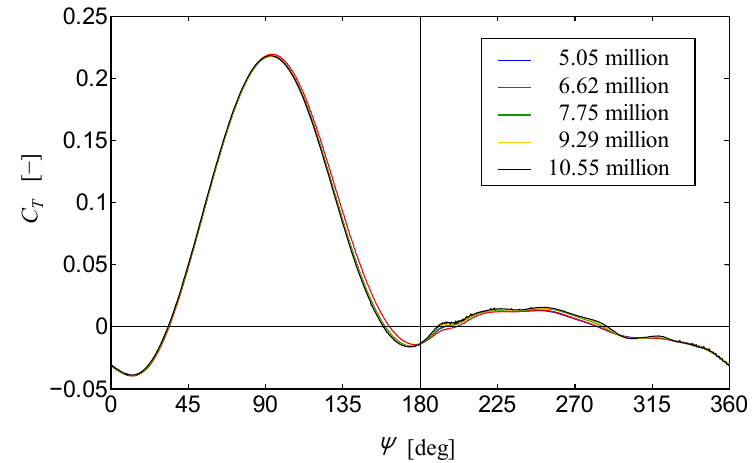
Figure A1. Mesh dependency of the torque variation of a blade of the armless rotor ( λ = 3).